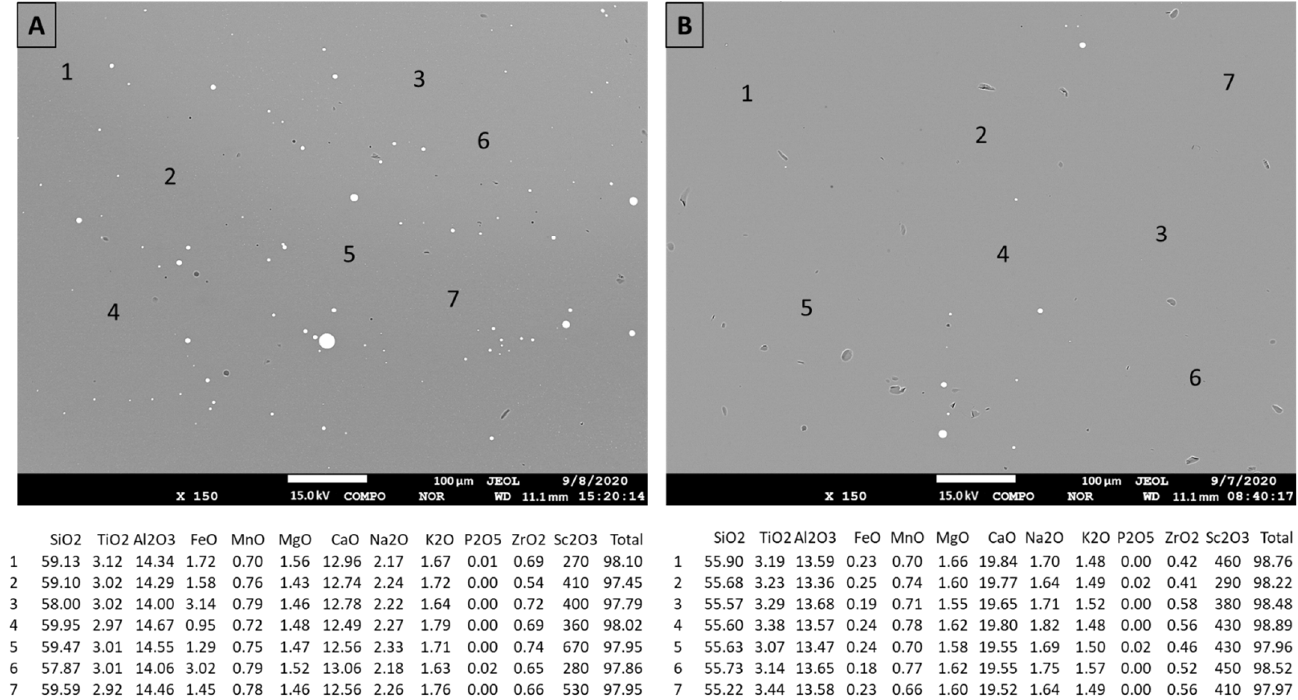
Figure 3. Back-scattered electron images of slag with EPMA analysis point locations and corre- sponding results in wt% after reduction experiments with the R2/l concentrate conducted at 1450 °C. ( A ) Slag produced in the first part of our pyrometallurgical study without additions [9]. ( B ) Slag produced with 5% addition of CaO in this study. Table 5. Average chemical compositions determined with EPMA for slags produced in reduction